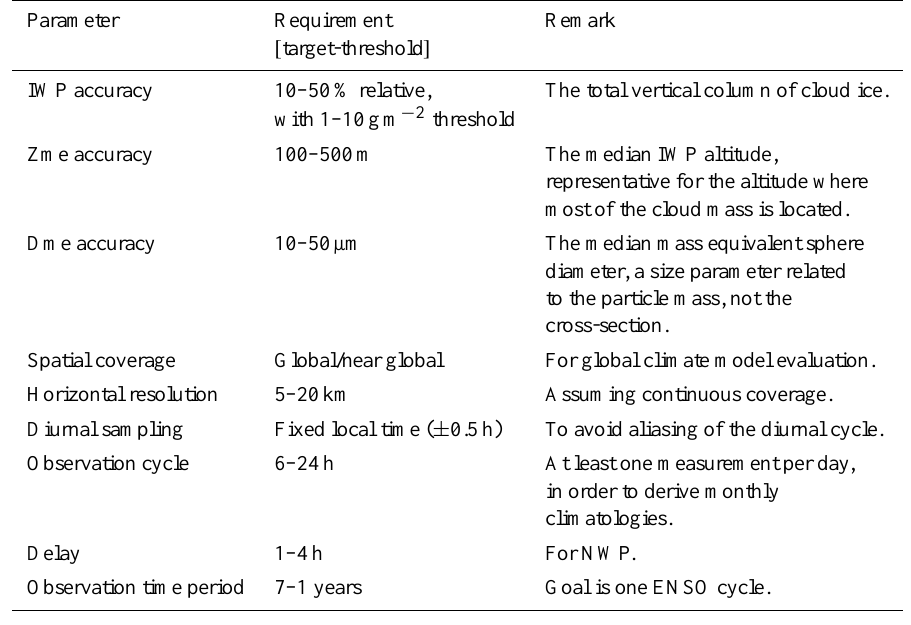
Table 2. Scientific mission requirements for a passive submillimeter-wave cloud ice mission, derived from breakthrough ranges in the pure scientific requirements for cloud ice observation. See Table 5 for parameter definitions. Delay requirements refer to numerical weather prediction (NWP) applications, since for climate and GCM validation/development applications the delay is not critical. The accuracy requirement for IWP is the maximum of relative accuracy and threshold for each IWP value. The horizontal resolution requirement assumes continuous coverage, which requires an appropriate footprint overlap. The table is an expanded version of Table 4 in Buehler et al. (2007) with more detailed comments. The requirement numbers themselves are identical.